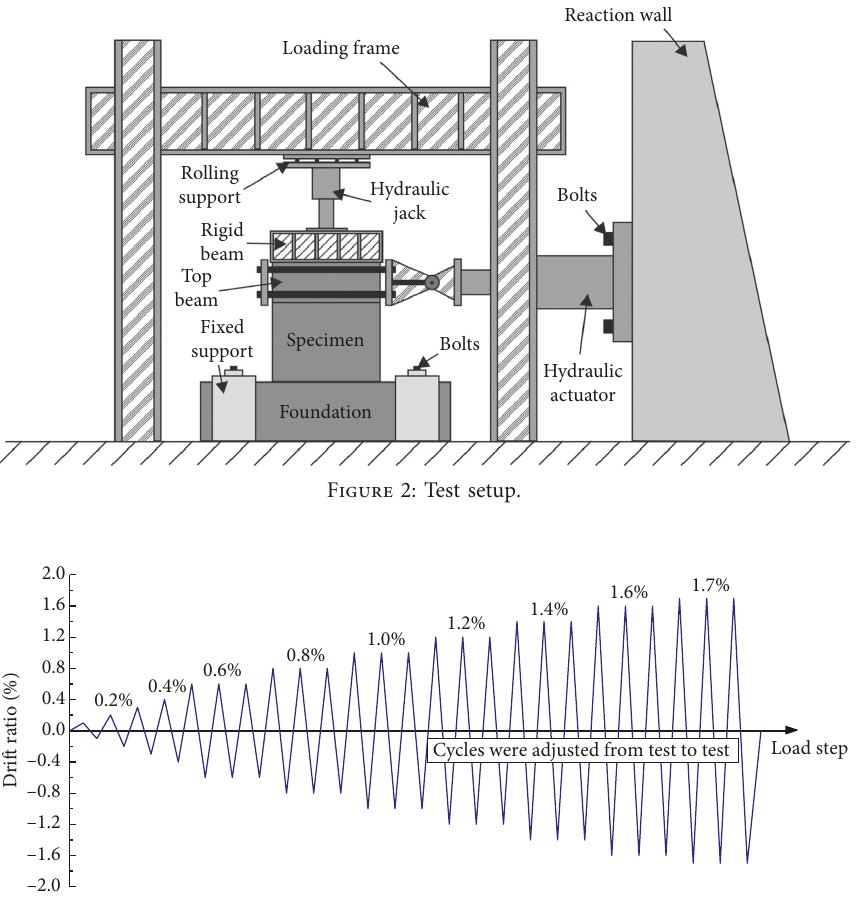
Figure 3: Loading history.